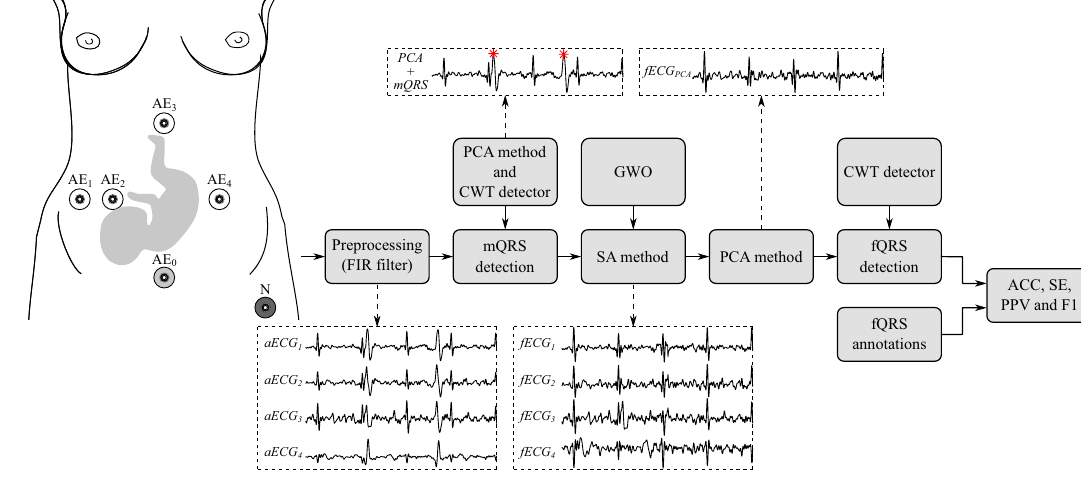
Figure 2. Block scheme of proposed